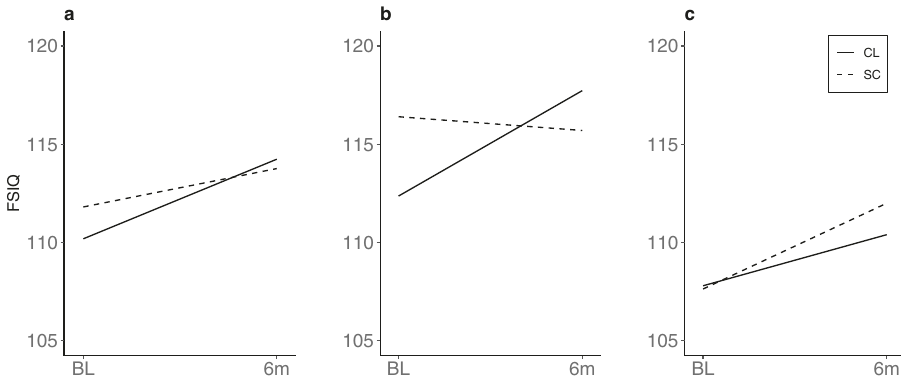
c Baseline % glucose >250mg/dl >25%. Line charts show change from baseline (BL) to end of study at 6 months (6m). Trajectories for Closed Loop (CL) and Standard Care (SC) groups are shown.